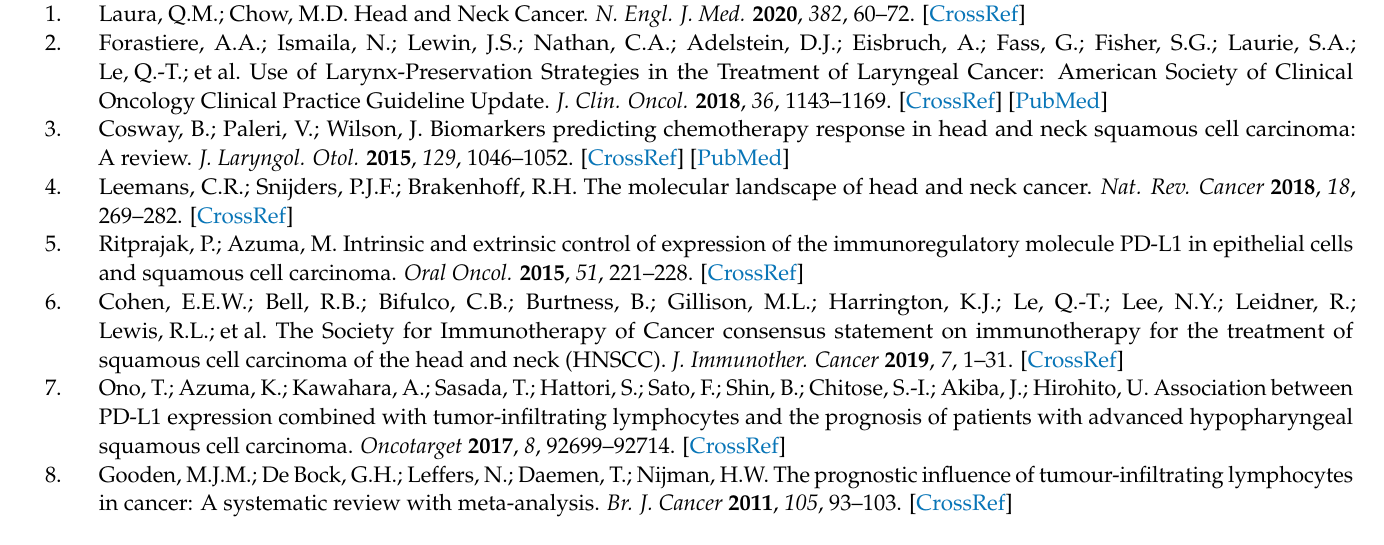
values calculated are shown. Figure S3: Disease-specific survival curves categorized according to neutrophil-to-lymphocyte ratio (NLR; A, B), PD-L1 composite proportion score (CPS; C,D), and CD8+ TIL density (E,F), in the subsets of patients treated with chemoradiotherapy or surgery. Figure S4: Disease-specific (A) and overall survival curves categorized according to the type of immune tumor